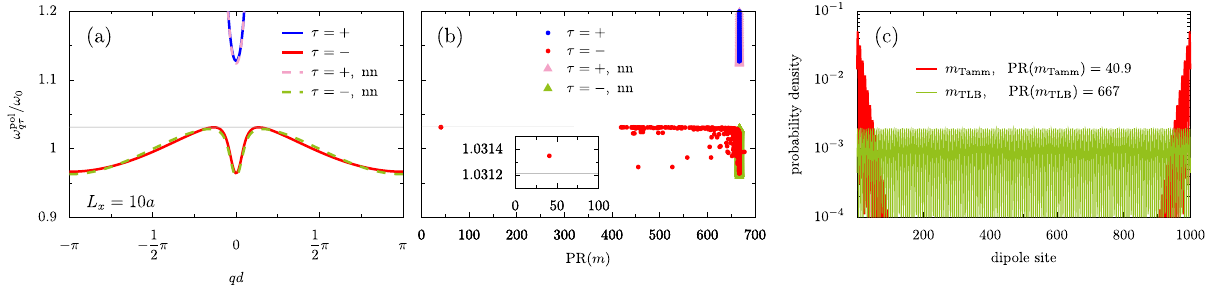
Figure 3: Panel (a): the polariton dispersion in the first Brillouin zone, with all-neighbor coupling ω pol q τ (nearest-neighbor coupling ω pol , nn q τ ) (cf. Eq.(11)).Theupper τ = + polaritonbandisdenotedbysolidblue(dashedpink)lines,andthelower τ = − polaritonbandisdenotedbysolidred (dashedgreen)linesforall(nearest)-neighborcoupling.Horizontalgrayline:guidefortheeyeattheeigenfrequencywhichcorrespondstothe top of the bulk band. Panel (b): the polariton eigenfrequencies with all-neighbor coupling ω pol m (nearest-neighbor coupling ω pol , nn